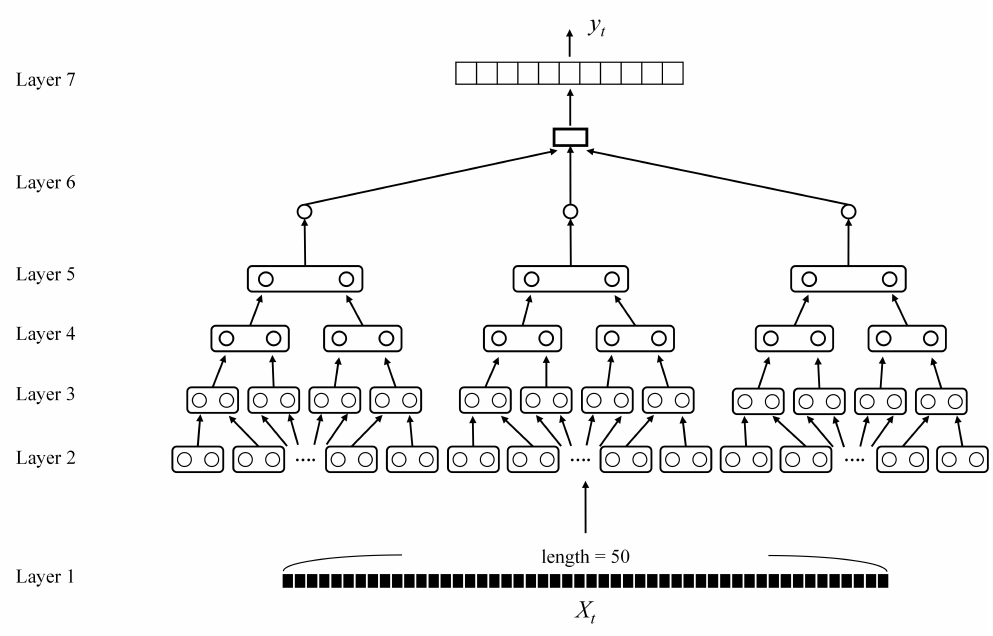
Figure 5. The structure of PairNet. In this example, the length of X t is N = 50. There are seven layers in the network. Layer 1 is a basic convolution layer. Layers 2–5 are convolution layers supporting pairing operations. Layers 6 and 7 are pooling layer and fully-connected layers, respectively.